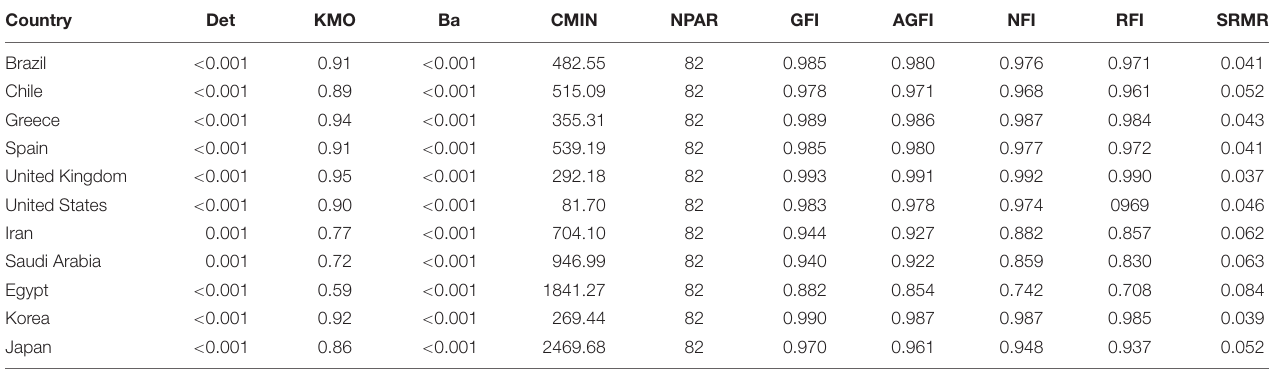
TABLE 3 | Matrix characteristics and fit of the MTMM model for the SCS. Country